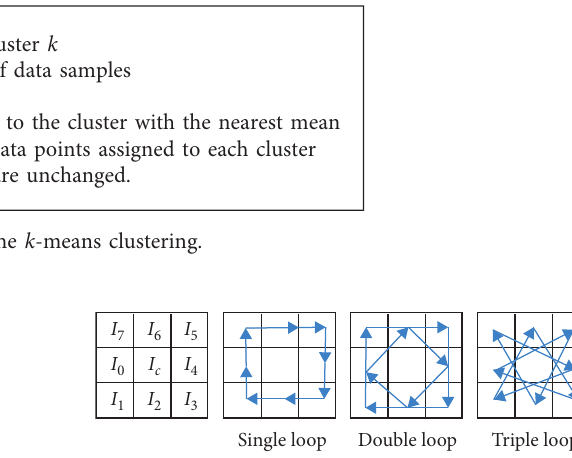
Figure 2: The graphical representation